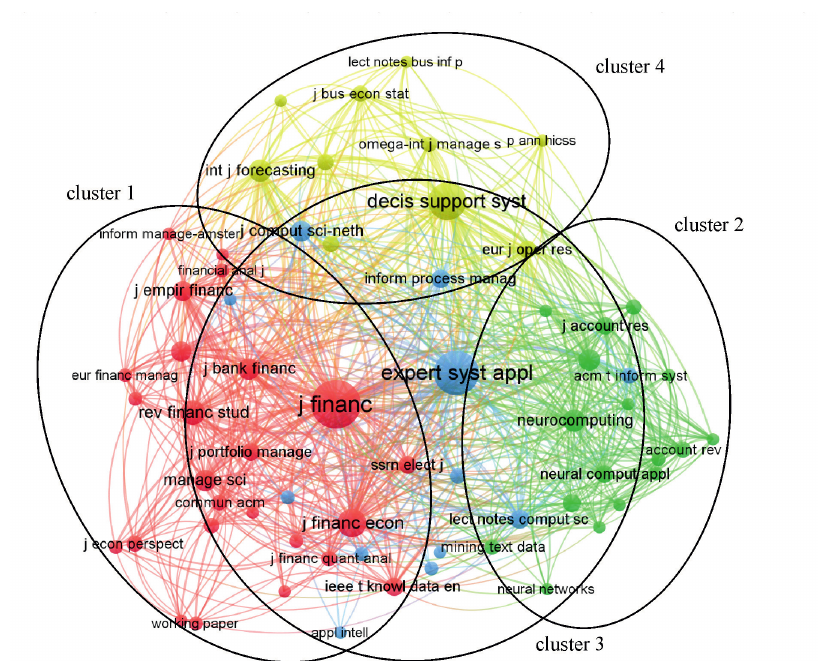
Figure 3. Results of bibliometric co-citations of journals